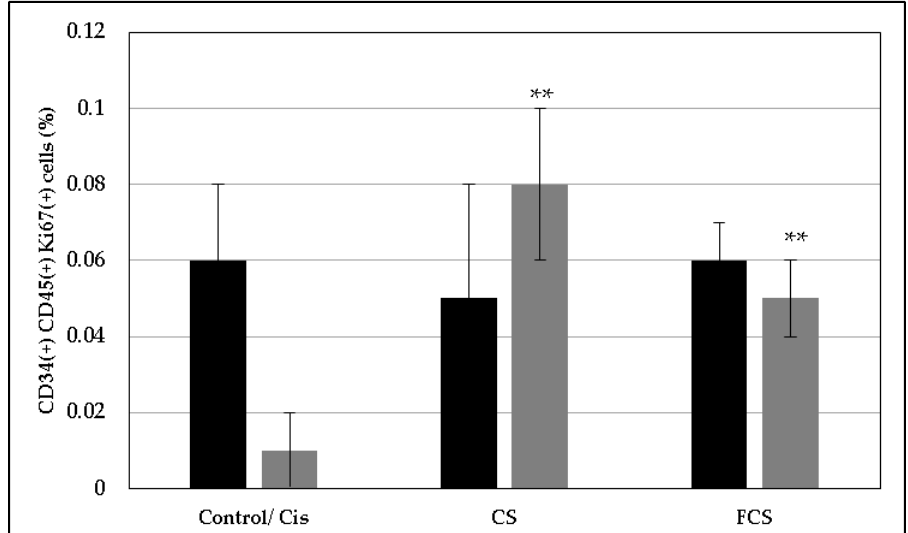
Figure 8. Concentration of CD34(+)CD45(+)Ki67(+) cells (%) after the treatment with chondroitin sulfate ( CS ) and fucosylated chondroitin sulfate ( FCS ) (mean ± SD). ■ Bone marrow cells, ■ bone marrow cells after cisplatin exposure. ** p < 0.05 vs. Cis.